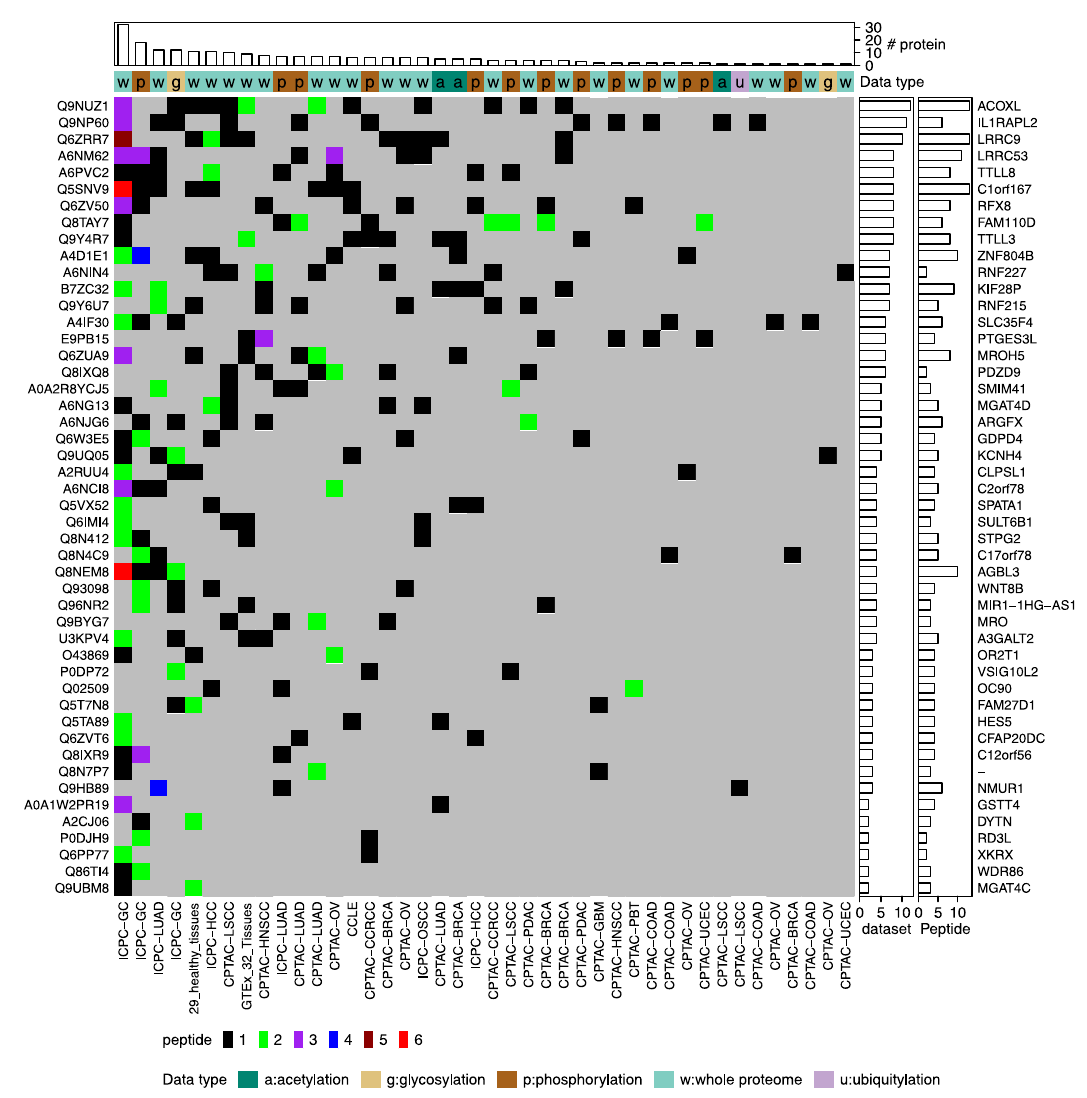
Fig.6 |Missingproteinidenti fi cation. The distributionofmissingproteinidenti fi cationsacrossdifferentMS/MSdatasetsinPepQueryDB.Sourcedataareprovidedasa Source Data fi